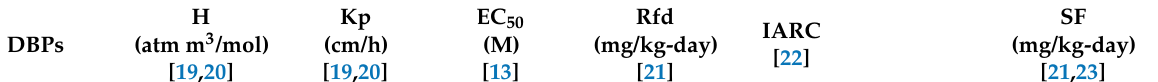
Table 4. Properties and risk factors used for assessing exposure and health